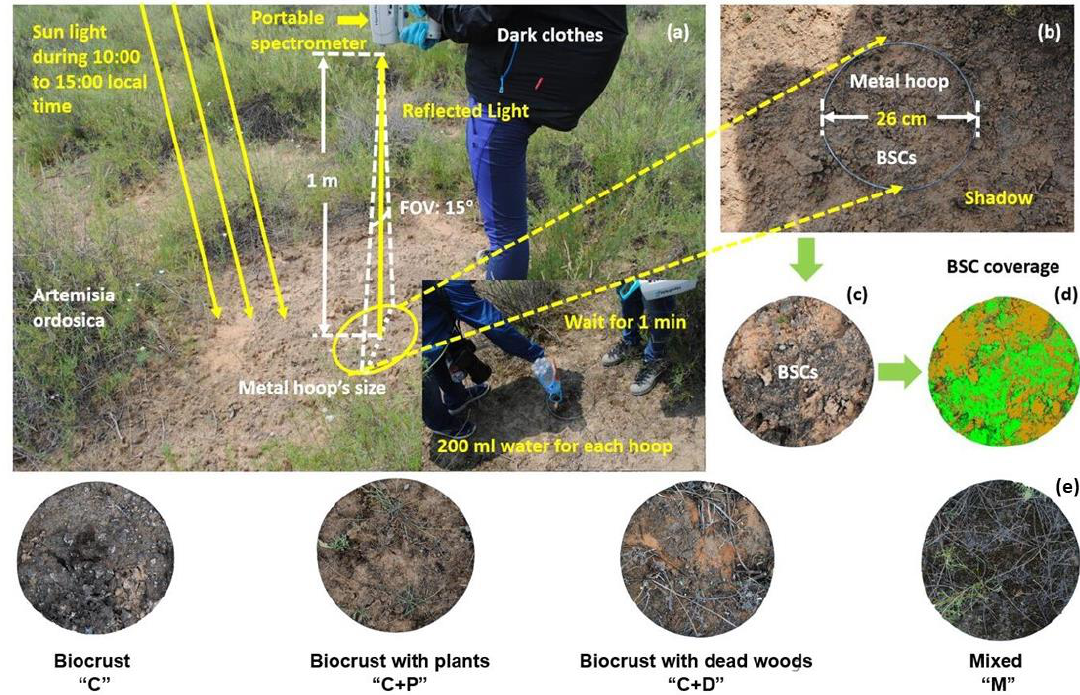
Figure 2. Fieldwork schematic. This figure is a modification of a previous work [17] and shows ( a ) in-situ spectral reflectance measurements; ( b ) metal hoop used for photographic assessment of biological soil crust (BSC) coverage; ( c ) clipped photograph of the metal hoop; ( d ) BSC coverage assessment; and ( e ) four land-cover types.